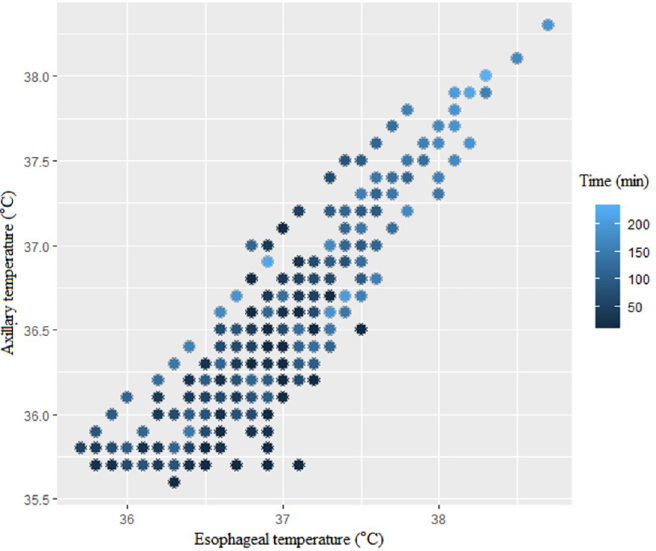
Fig 2. Scatter plot for esophageal and axillary temperatures (measurement time is indicated by colored circles).